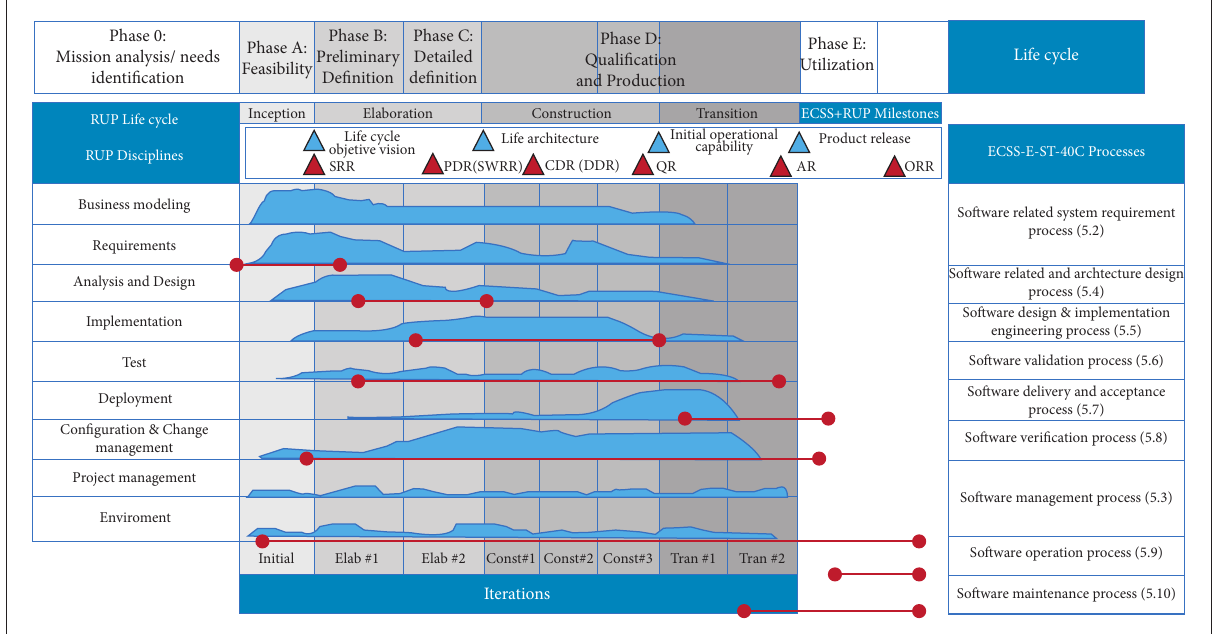
figure 3. ECSS-E-ST-40C and RUP life cycles